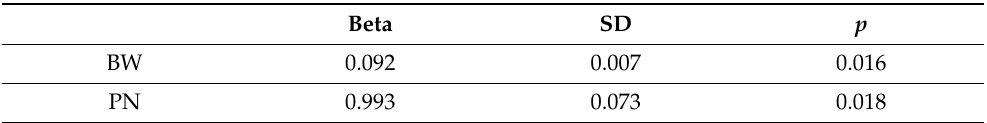
Table 3. Multivariate linear regression (R 2 = 0.72). SD, standard deviation; BW, birth weight; PN, parenteral